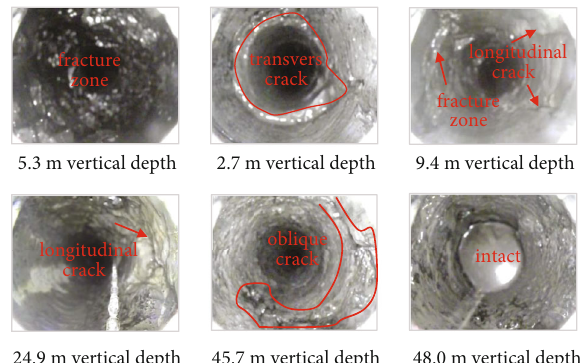
Figure 10: Floor failure depth measurement without RHF.